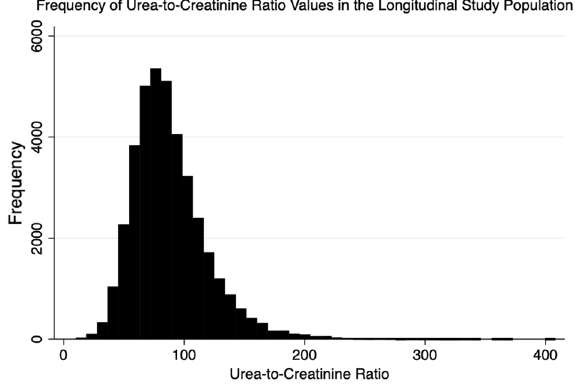
Figure 2. Distribution of admission UCR values. The mean admission serum urea-to-creatinine ratio in the population studied was 88.06 ( ± 31.46). The median admission serum urea-to-creatinine ratio was 83.13